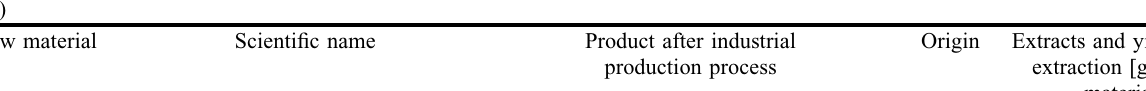
Table 1. Plant by-products for screening for in vitro activity against C. parvum . List of raw materials and extracts obtained from phytogenic by-products in the course of the EU project SAFEWASTES: (A) extracts and pure compounds related to olives, and (B) monensin. Extracts were abbreviated using the first letters of the genus and the specific epitheton, together with the type of extract produced: W = water extract, E = ethanol extract (70% (v/v)), H = heptane extract. Monensin was used as a positive control. Table according to Stockhammer et al. [40],